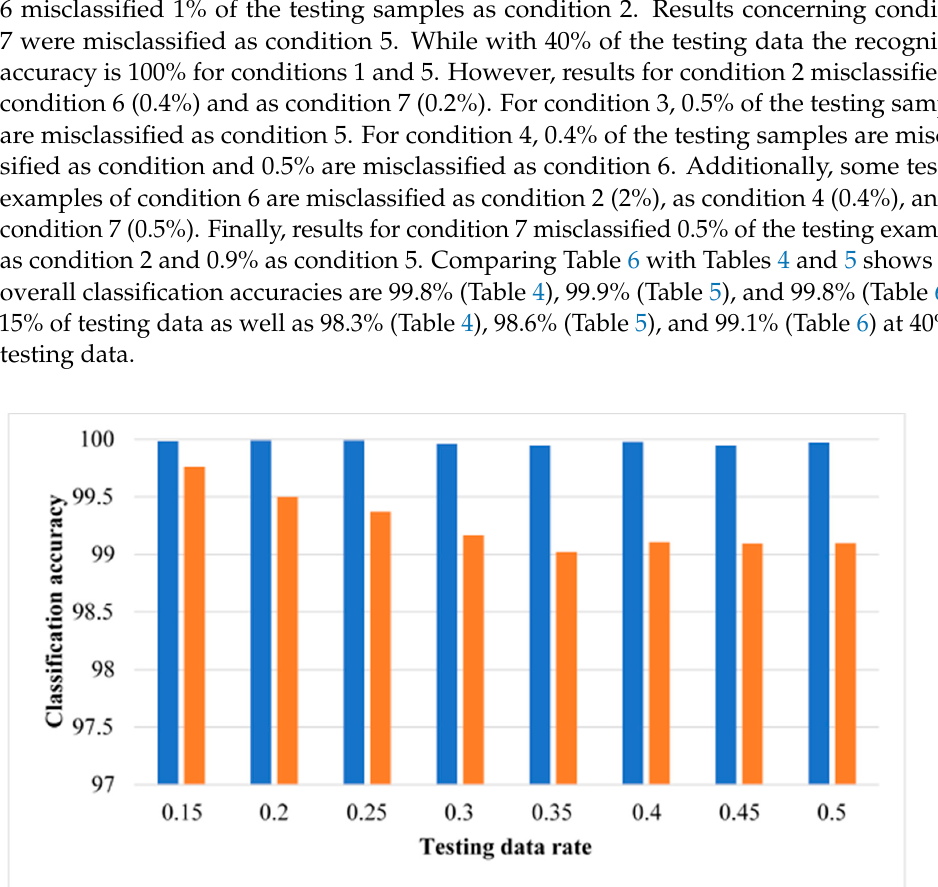
Figure 9. Classification results of training and testing data using MLR with data normalisation.